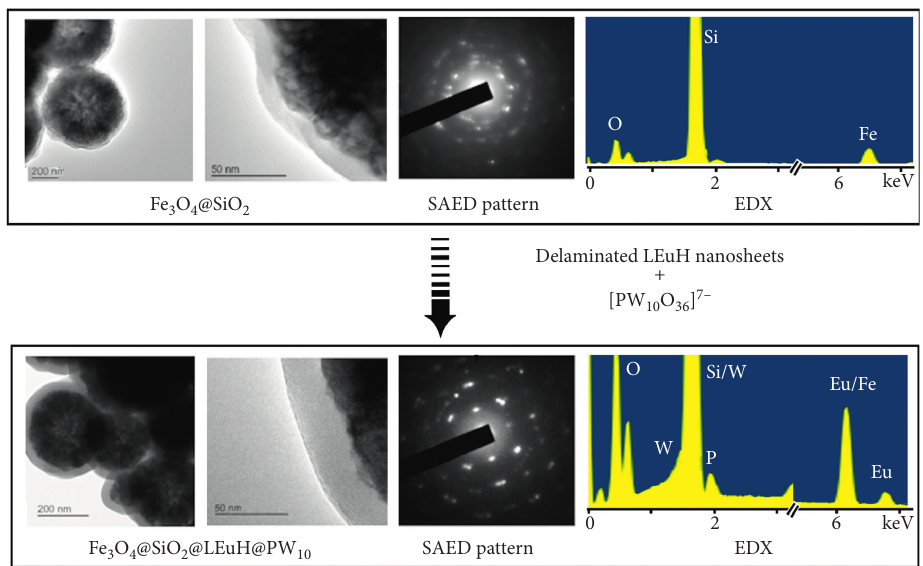
Figure 11: HRTEM, SAED patterns, and EDX images of the as-synthesized core-shell nanostructured PW silicon wafer).